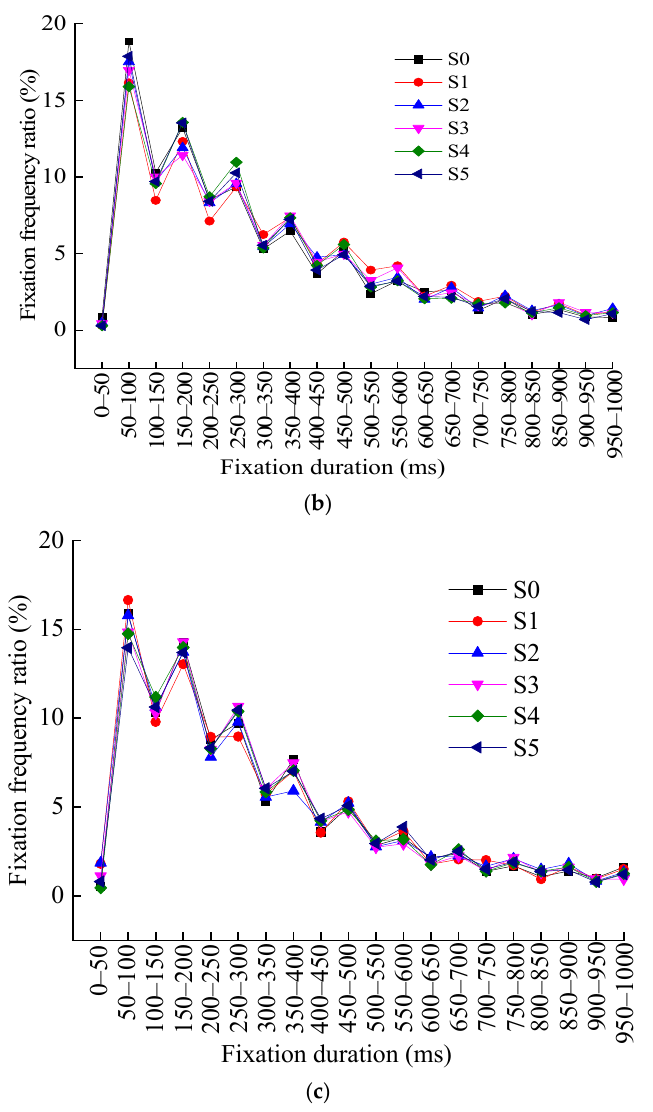
Figure 5. Distribution of driver’s fixation durations at different TSIV of the three speed conditions. ( a ) 60 km/h; ( b ) 80 km/h; ( c ) 100 km/h.